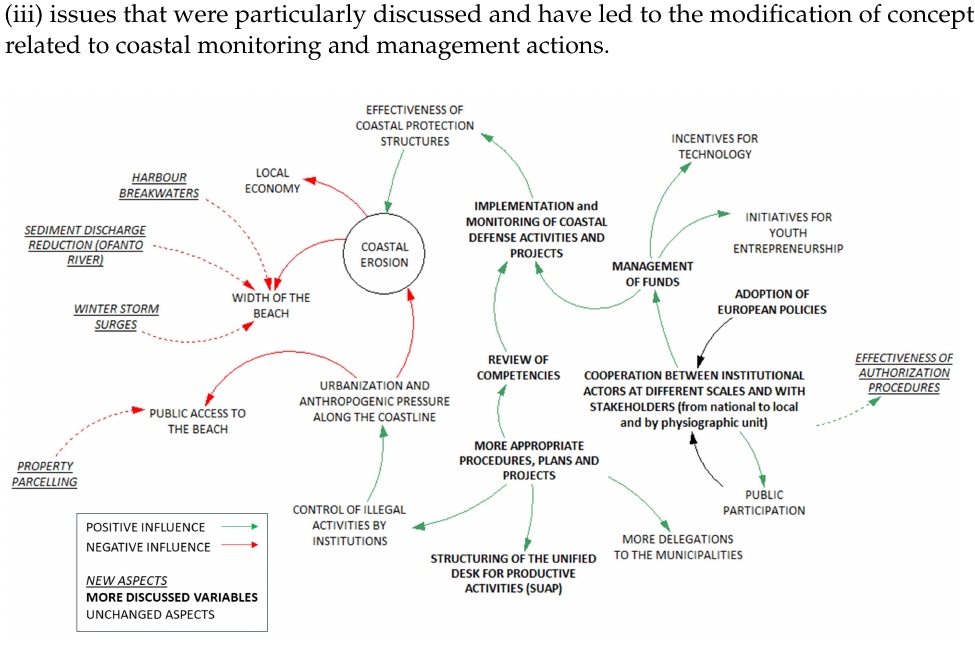
Figure 6. C-FCM of Step 4—the coastal risk perception in the test site as a result of the